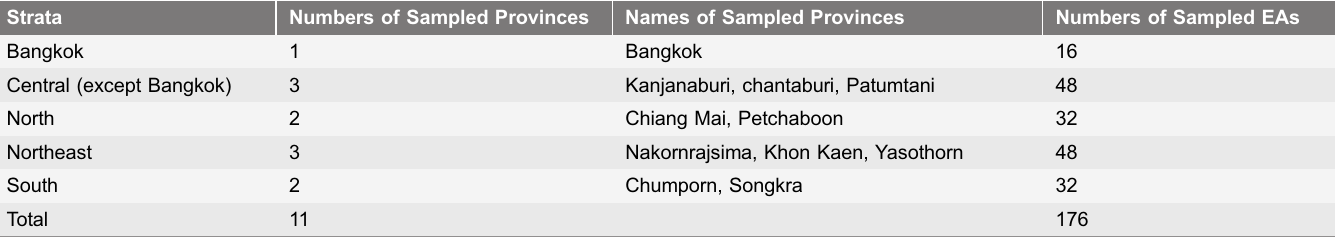
Table 1. Details of sampled provinces and enumeration areas (EAs) in each regional stratum.